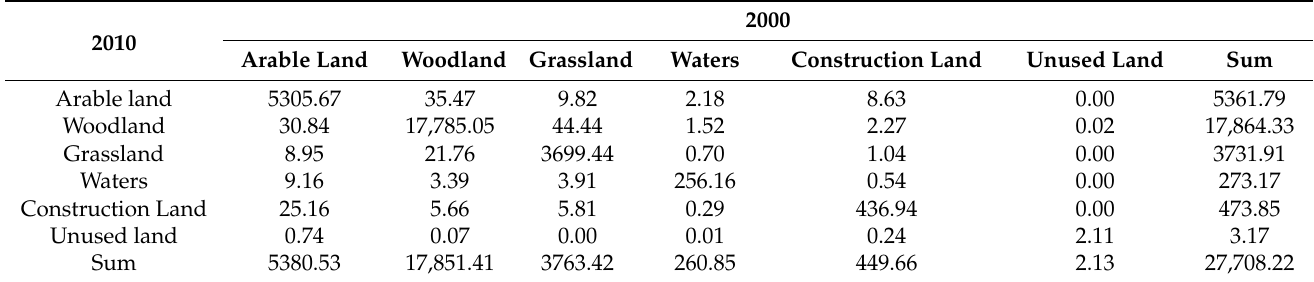
Table 3. Land-use type transfer matrix in Guilin from 2000 to 2010 (unit: km 2 ).